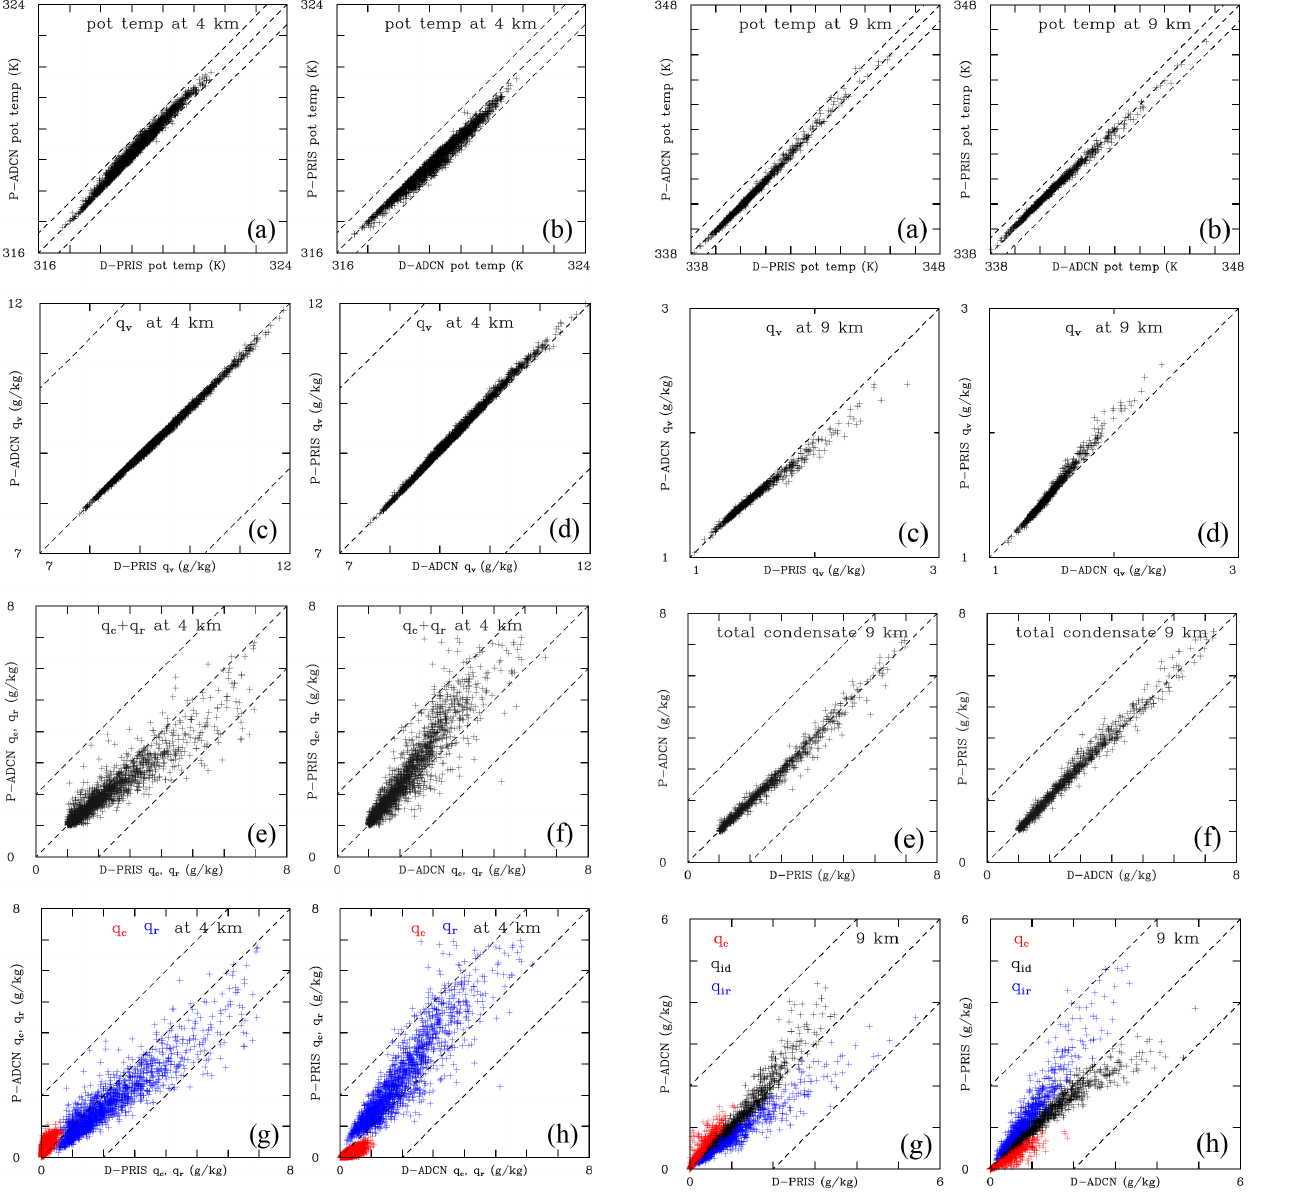
Figure 14. Like in Fig. 13, but for the upper panels of Fig. 13, that is, at 9km height. Dashed lines for q v (middle panels) are outside the range of q v values shown in the figure. The total loading compo- nent in (e, f) is split in (g, h) between cloud water (red), ice mixing ratio grown by diffusion of water vapor (black), and ice mixing ratio grown by riming